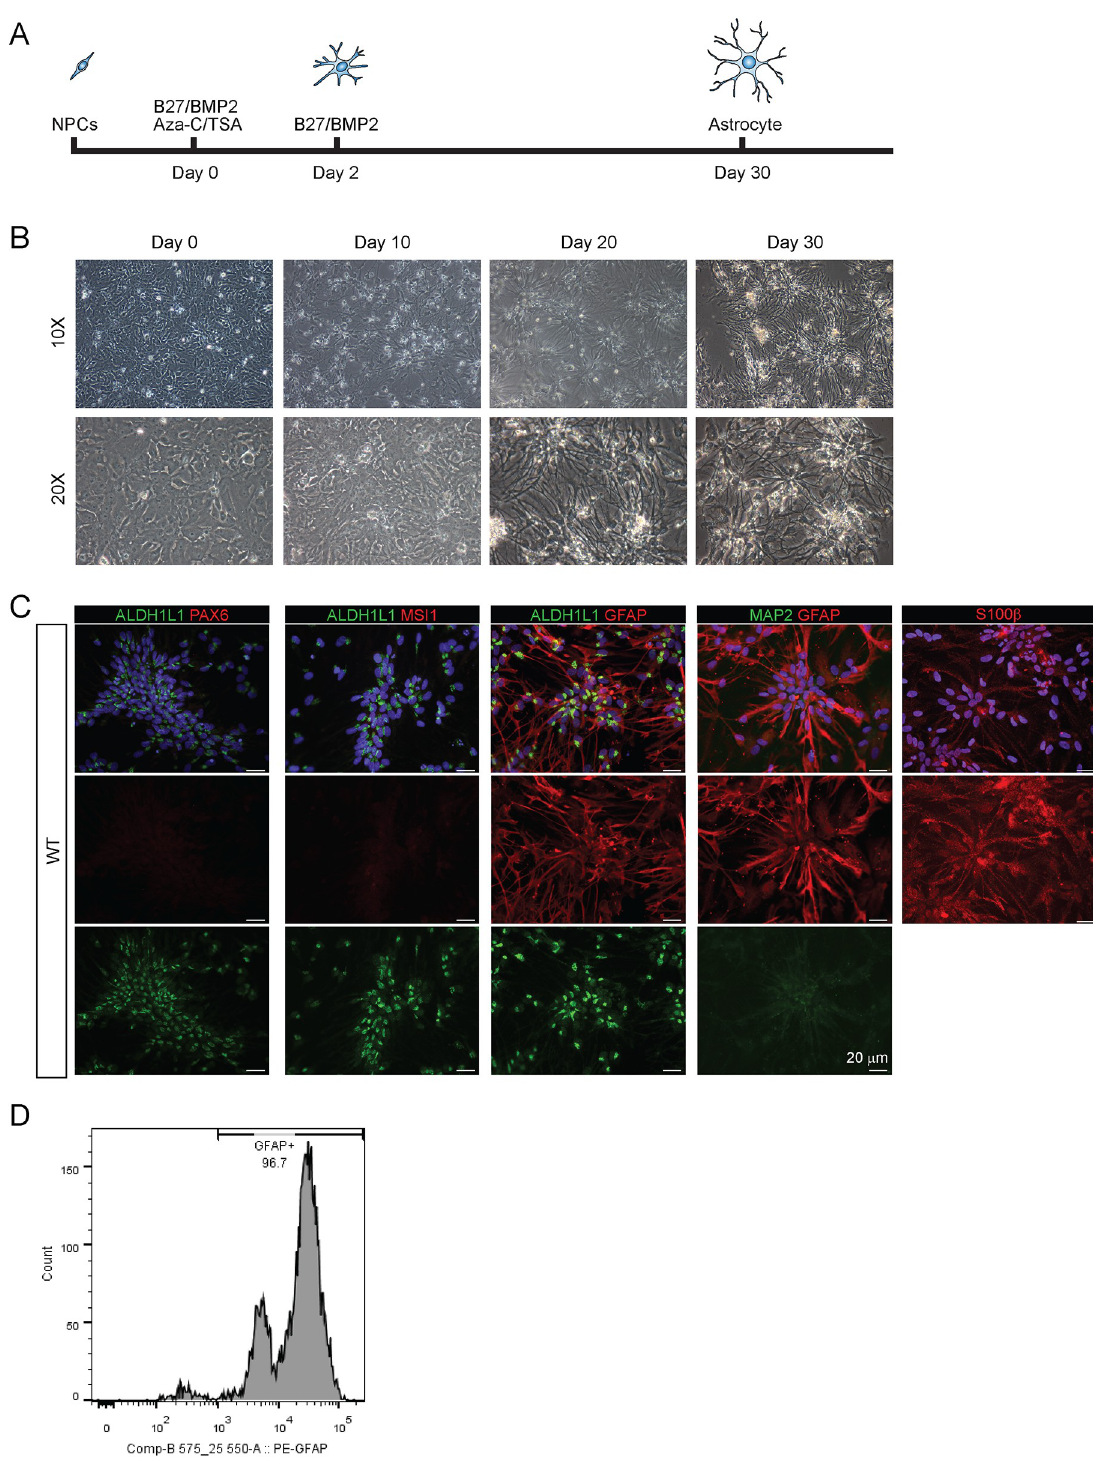
Fig 1. Differentiation of NHP NPCs to astrocytes in vitro . (A) Graphical description of differentiation protocol. NPCs were treated with BMP2, bFGF, Aza-C, and TSA for two days. After initial treatment, Aza-C and TSA were removed, and only BMP2 and bFGF were supplemented in the media. (B) Morphological changes during differentiation process showing development and elongation of processes. (C) Wild-type astrocytes are expressing astrocyte-specific proteins GFAP (red), ALDH1L1 (green) and S100 β (red), while no detectable NPC (PAX6 and MSI1) (red) and neuronal (MAP2) (green) specific proteins were expressed. (D) Fluorescence-Activated Cell Sorting showing the population of cells that positive for GFAP.